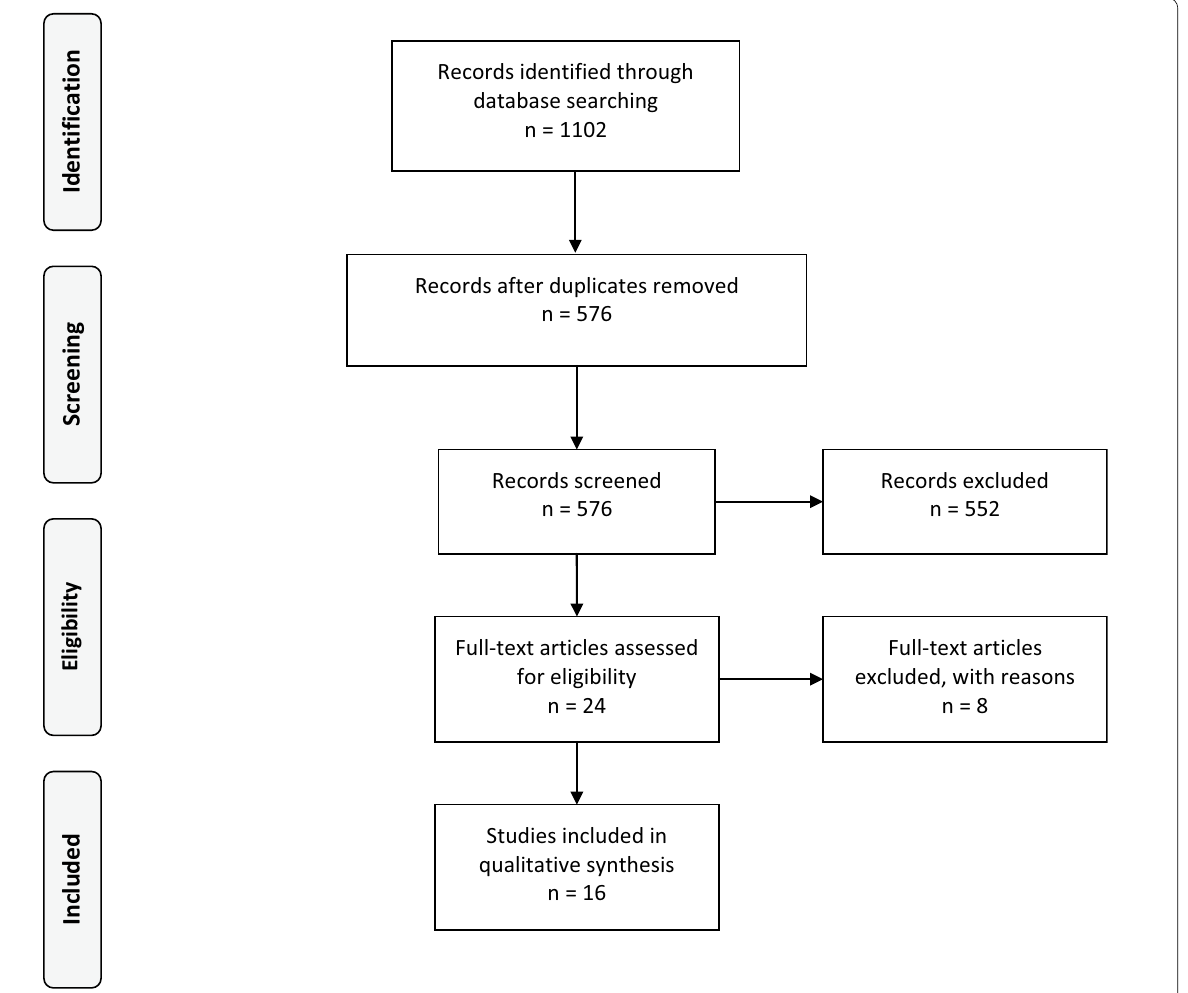
Fig. 1 PRISMA flow diagram of the literature